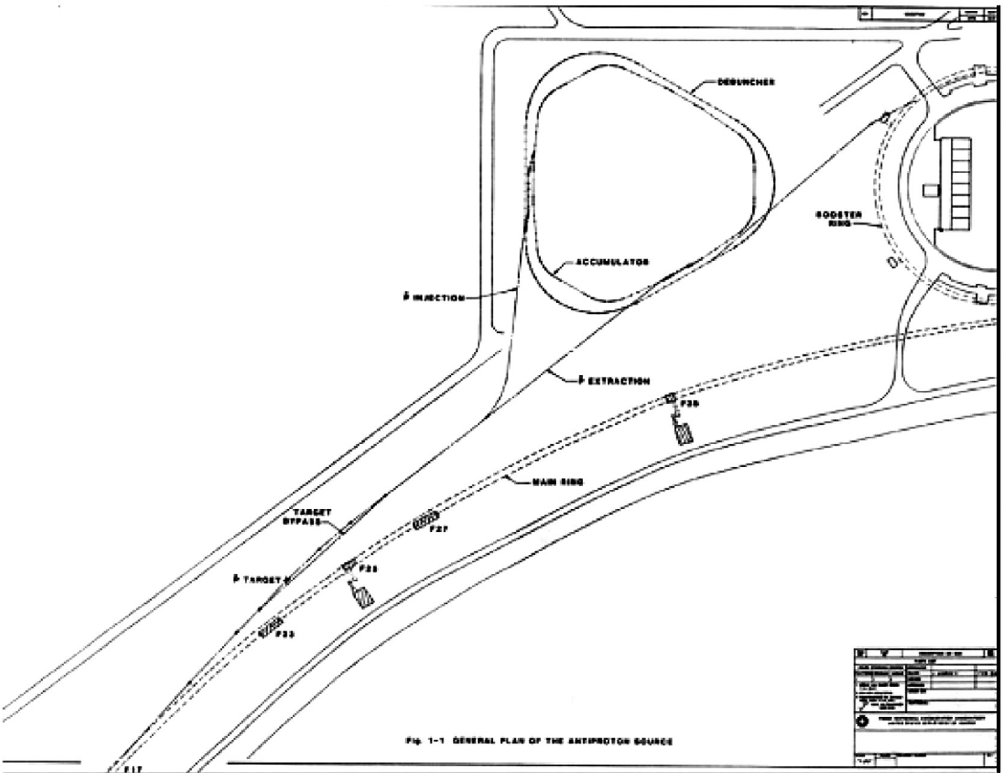
FIG. 3. Antiproton Source (From